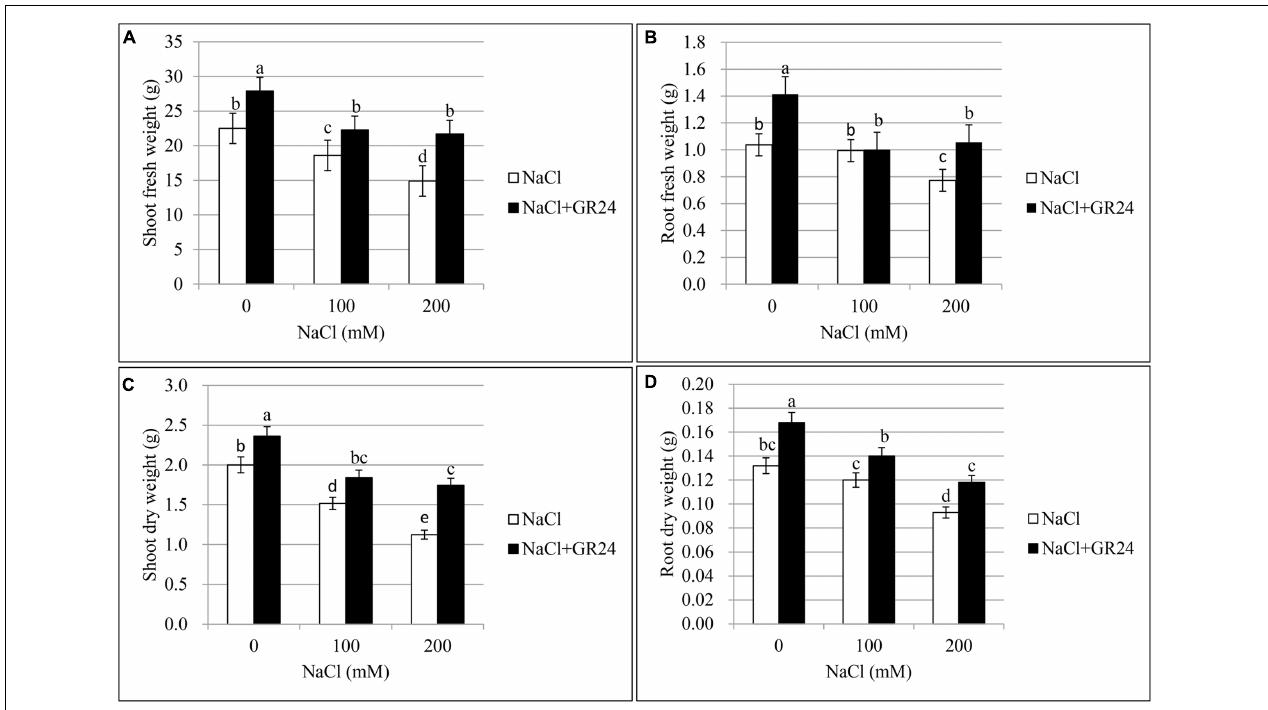
FIGURE 1 | Effects of GR24 and salinity stress on the shoot (root) fresh weight, shoot (root) dry weight of seedlings in Brassica napus cv. ZS 11. Shoot fresh weight (A) , root fresh weight (B) , shoot dry weight (C) , and root dry weight (D) at 7 days in the presence of GR24 (0.18 µ M) and salinity (0, 100, and 200 mM NaCl, respectively) in ZS 11 ( n = 10). All experiments were repeated three times and the data represent means ± SE. Means followed by same small letters are not significantly different by the LSD test at P ≤ 0.05